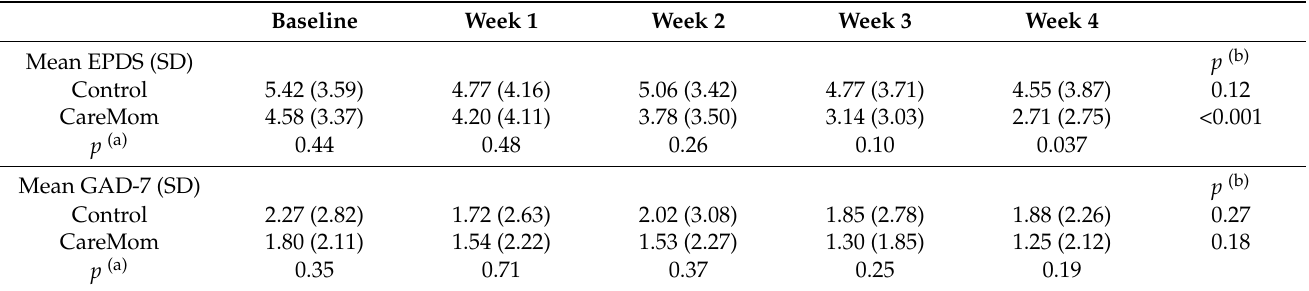
Table 3. Mean EPDS and GAD-7 scores of the participants who completed the study, at baseline and weeks one to